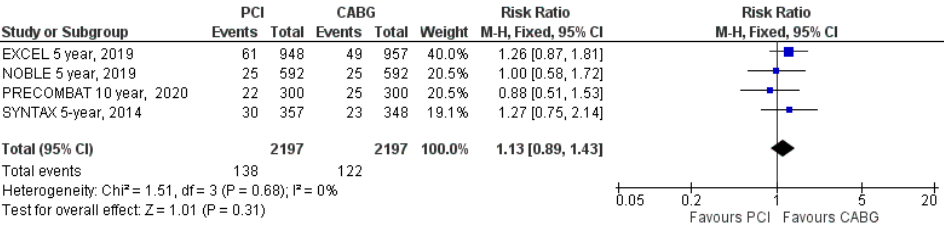
Figure 4. Risk of cardiovascular mortality at latest follow-up: PCI vs. CABG.